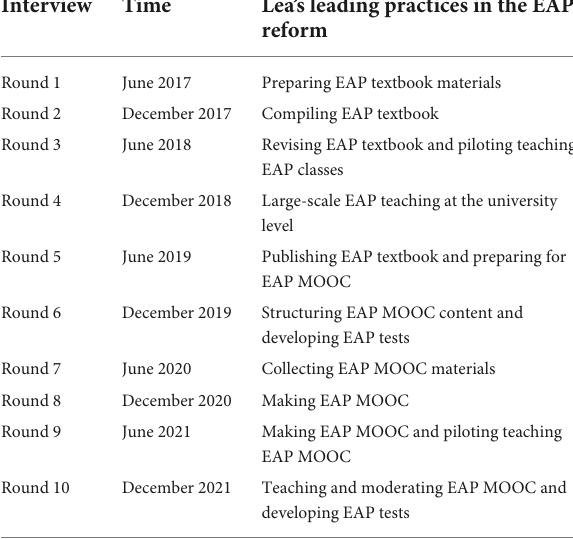
TABLE 1 Timeline of data